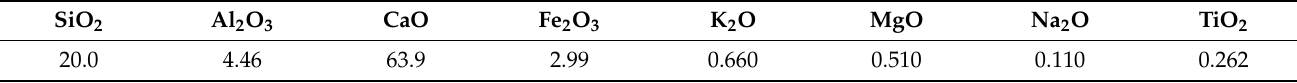
Table 1. Chemical composition of P.II 52.5 Portland